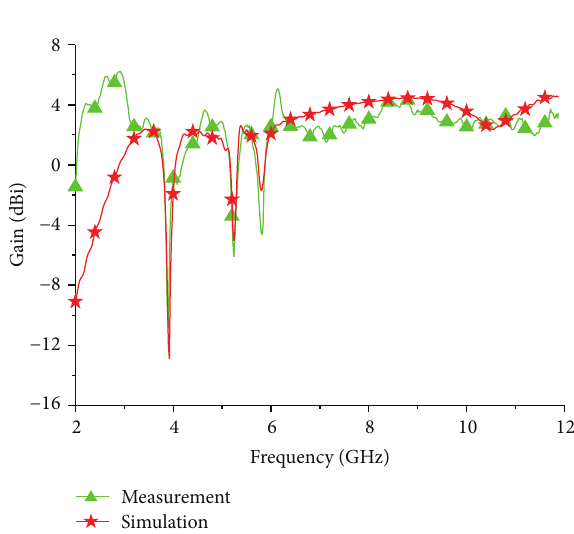
Figure 7: Comparison of simulated and measured gains of the pro- posed antenna.